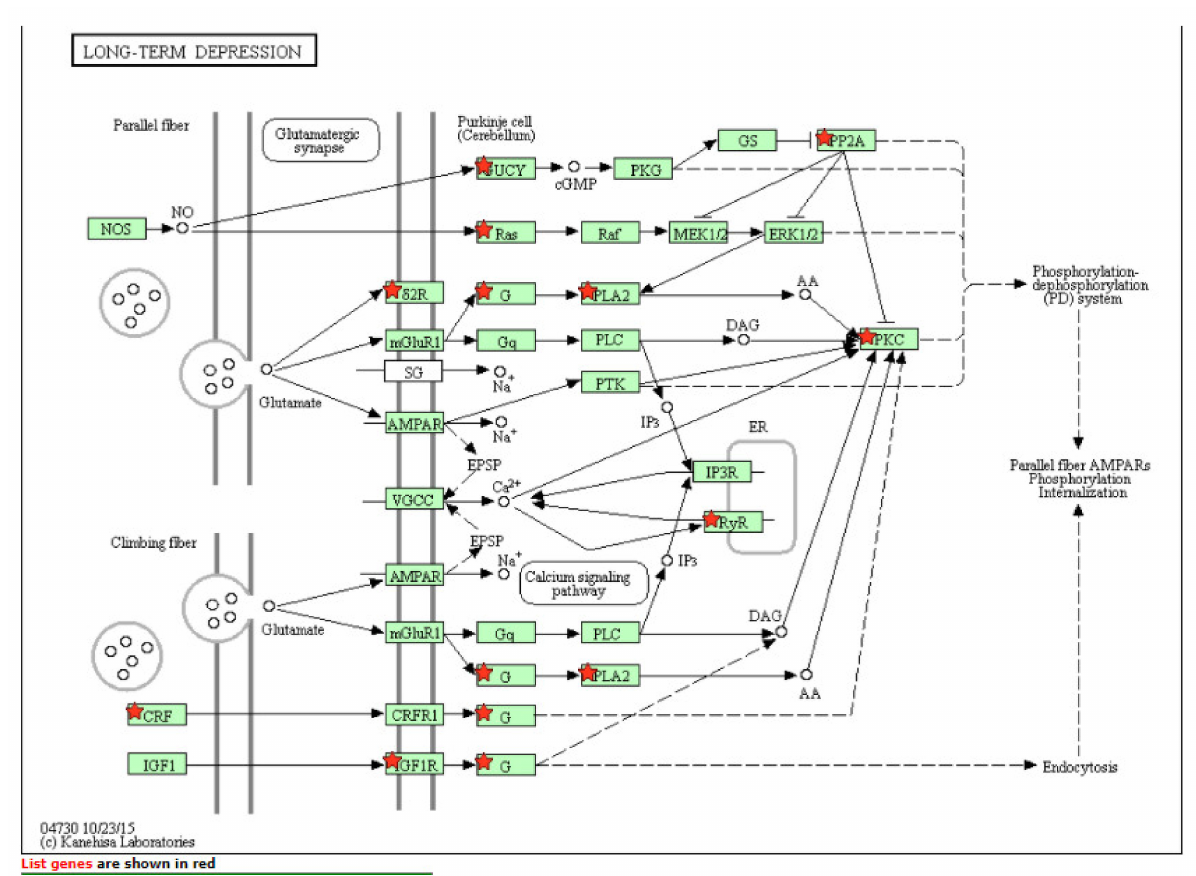
Figure 1. Long-term depression pathway.